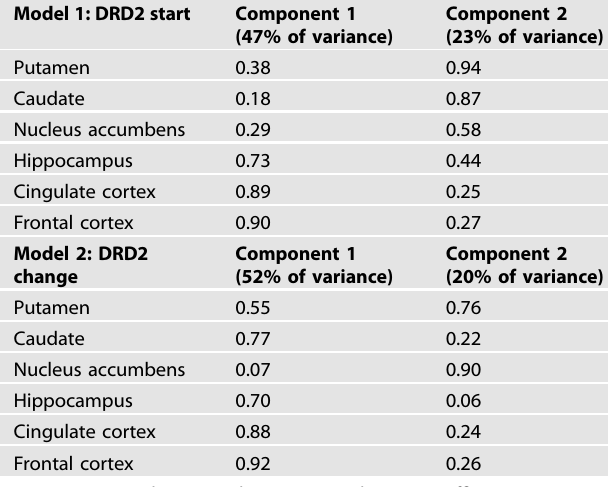
Table 2. Results from principal component analyses for DRD2 levels at study entrance (model 1), and for DRD2 change (model